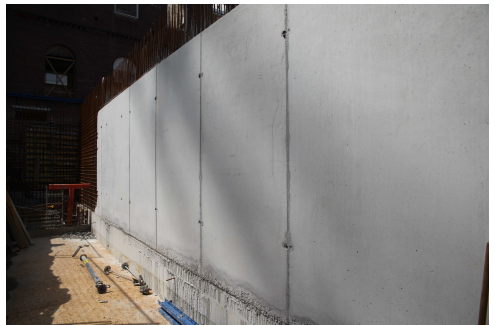
Figure 3: Texture-poor surfaces such as concrete walls result in a lower amount of detected feature points complicating both the alignment as well as the further reconstruction possibility to design an algorithm that deletes erroneous recon- structions under the floor level. This will be researched in the